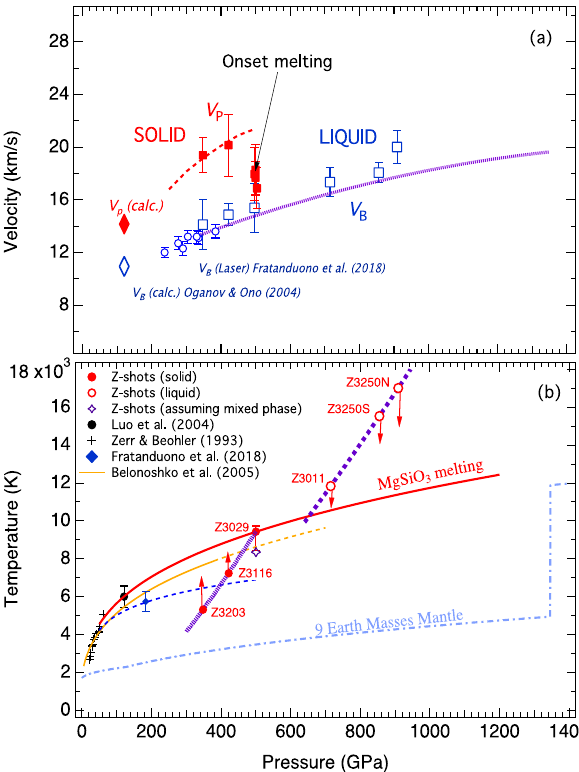
Fig. 2 Comparision of the measured sound velocities and melting temperature of MgSiO 3 at high pressure with results from previous studies. a The bulk sound velocities ( V B ) along Hugoniot are shown by the blue open squares, compared with theoretical calculations of this study (purple dotted line). The measured bulk sound velocities of liquid MgSiO 3 enstatite target by laser-driven shock 13 are also plotted for comparison. The longitudinal velocities ( V p ) of the solid phase are shown by the red solid squares. The calculated values of V p and V B for post-perovskite at 125 GPa 27 are also shown for comparison. b The Z shots supporting longitudinal wave (red solid circles) are plotted on the calculated Hugoniot for solid post-perovskite (thick purple dotted line) whereas the experiments shocked into a liquid are plotted on the calculated liquid Hugoniot (thick purple dashed line). The red curve represents the melting curve fi tted to the upper bound melting constraint at 500 GPa along with low-pressure constraints from gas-gun compression of glass (black solid circle) 12 and static experiment (crosses) 11 . The vertical red arrows point toward melting temperatures. The open purple star indicates melting temperature assuming the shock entering a mixed phase. Theoretically calculated melting curve (yellow line) 28 and estimated melting point (blue diamond) and curve (blue dashed line) from laser-shock of enstatite 13 are shown for comparison. The temperature pro fi le of super-Earth with 9 M E used for density pro fi le calculation is also shown.